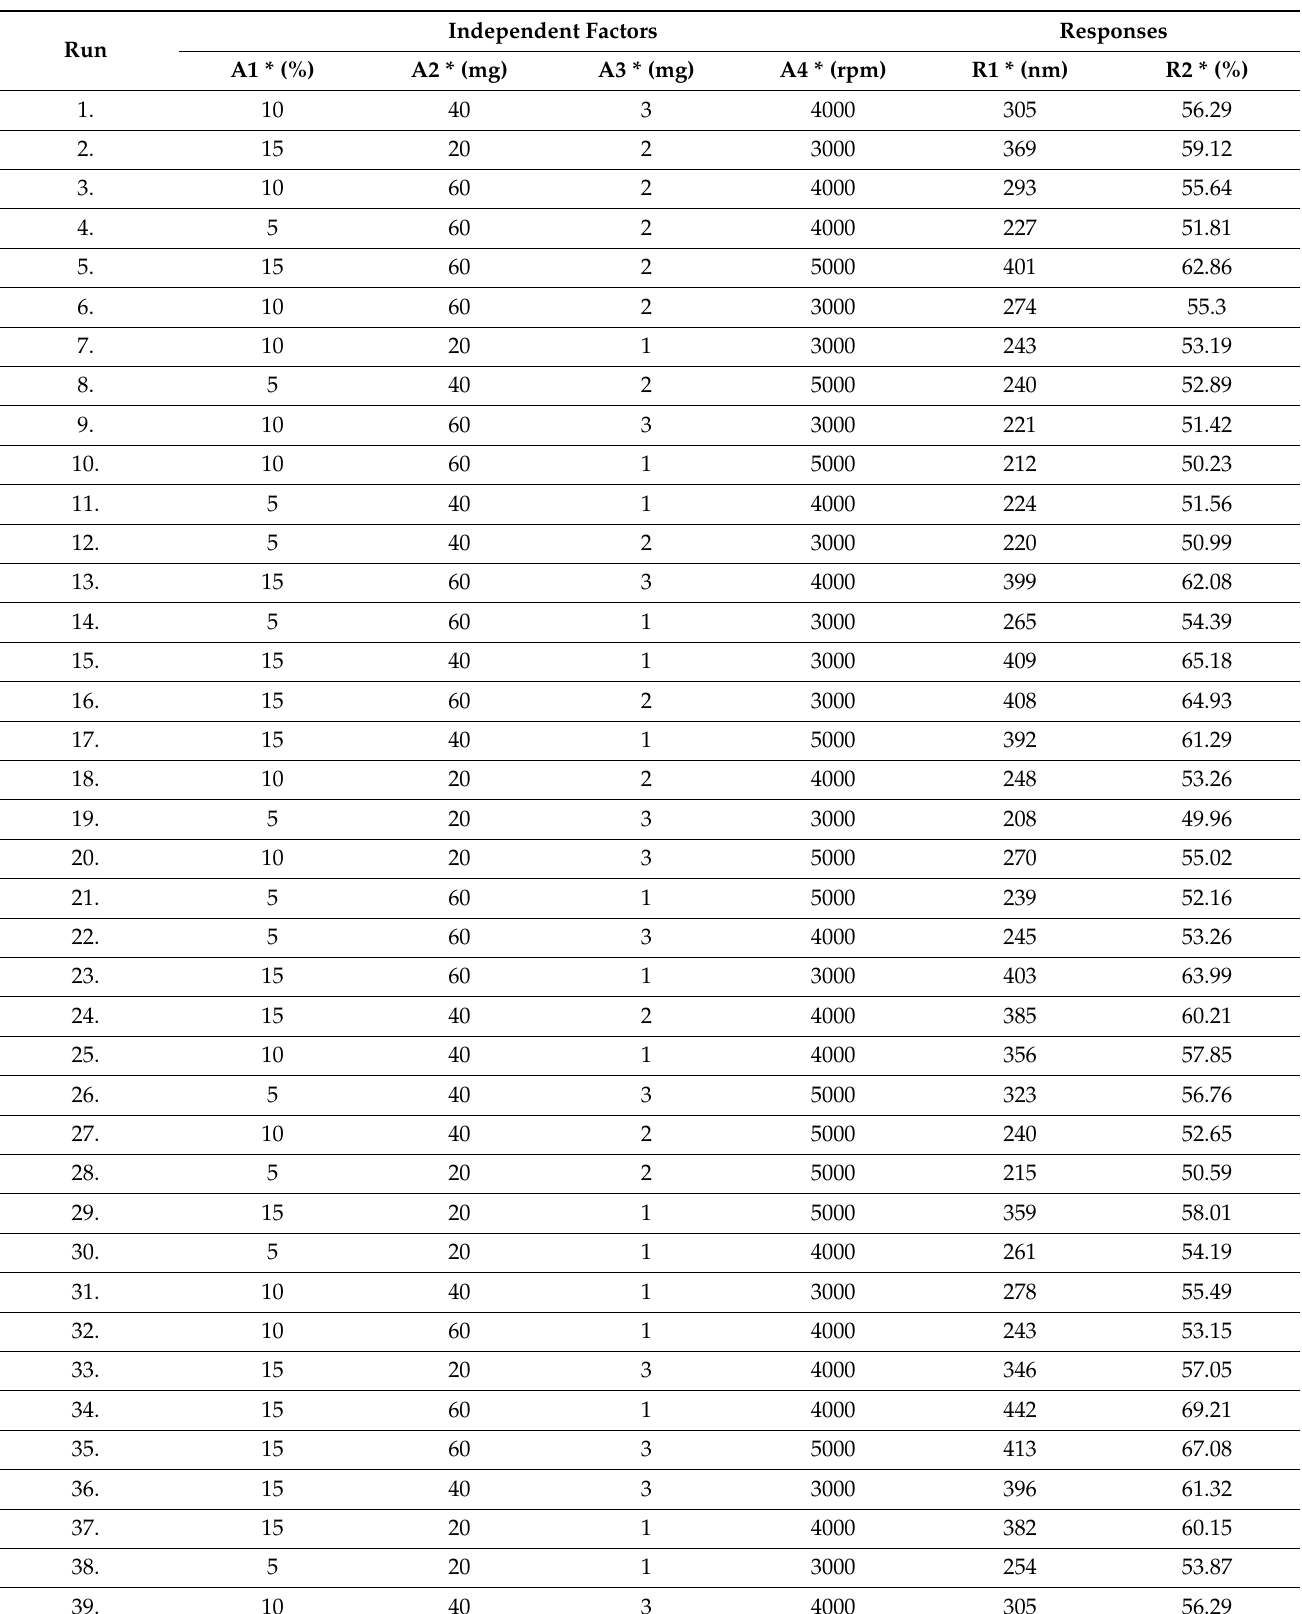
Table 1. Experimental design and responses obtained for the prepared Saxagliptin